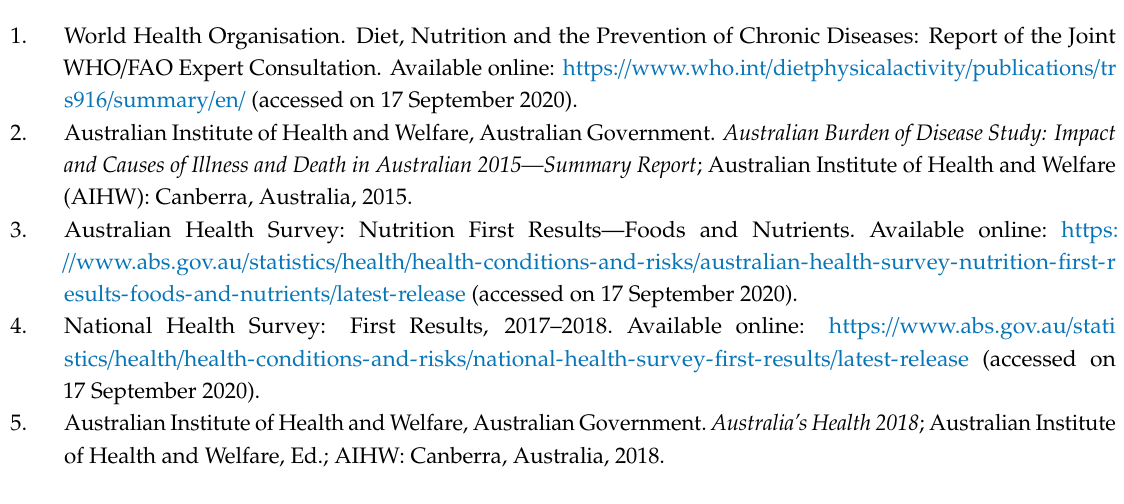
Table S1: Spontaneous exchanges related to diet; Table S2: Spontaneous exchanges related to physical activity; Table S3: Spontaneous exchanges related to the program; Table S4: Spontaneous exchanges related to other